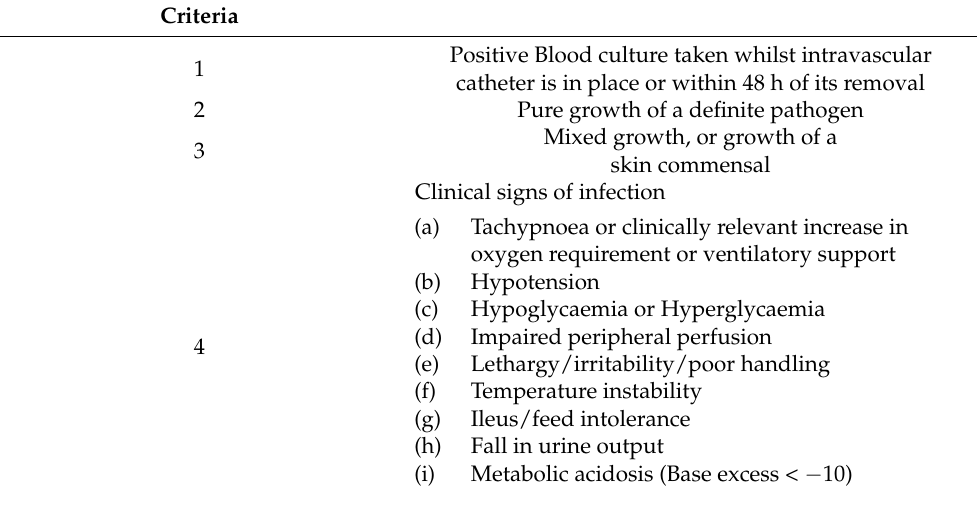
Table 1. Case definition criteria for Catheter Associated Blood Stream Infection (CABSI).